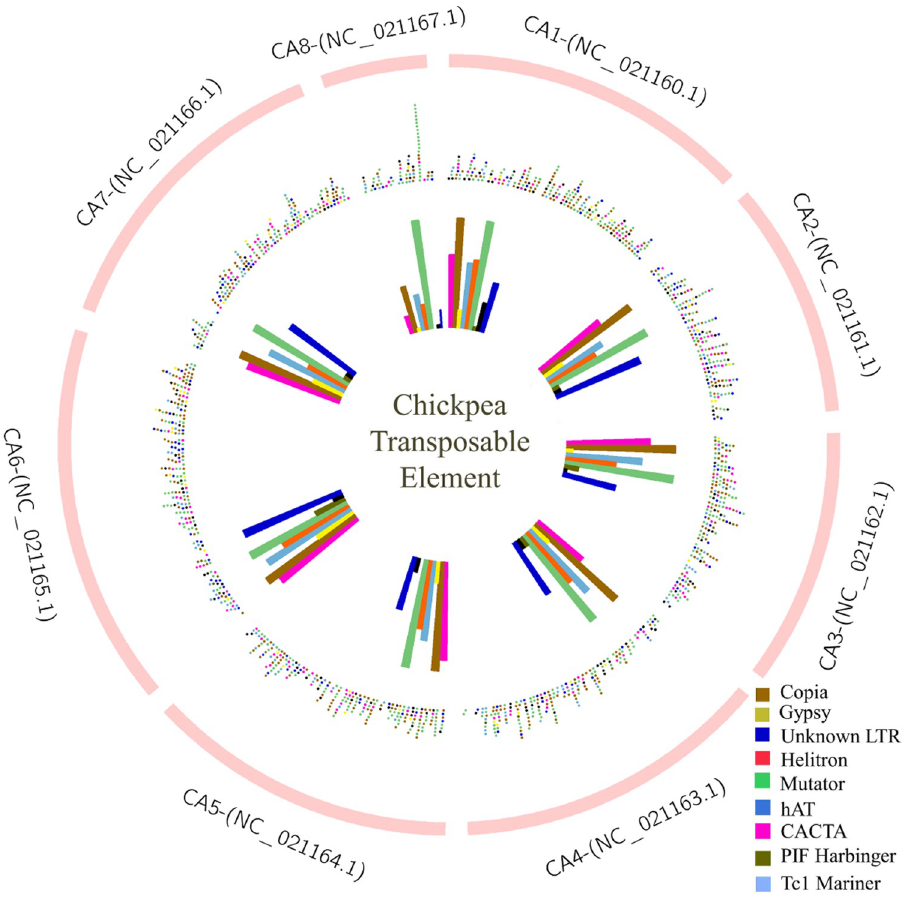
Fig 2. The distribution of intact TEs across eight chickpea chromosomes. The outermost circle in pink-colored represents eight C . arietinum chromosomes (CA1 to CA8). The middle circle illustrates the distribution of TE types in different colors, and the innermost circle shows the histogram of TE types in each